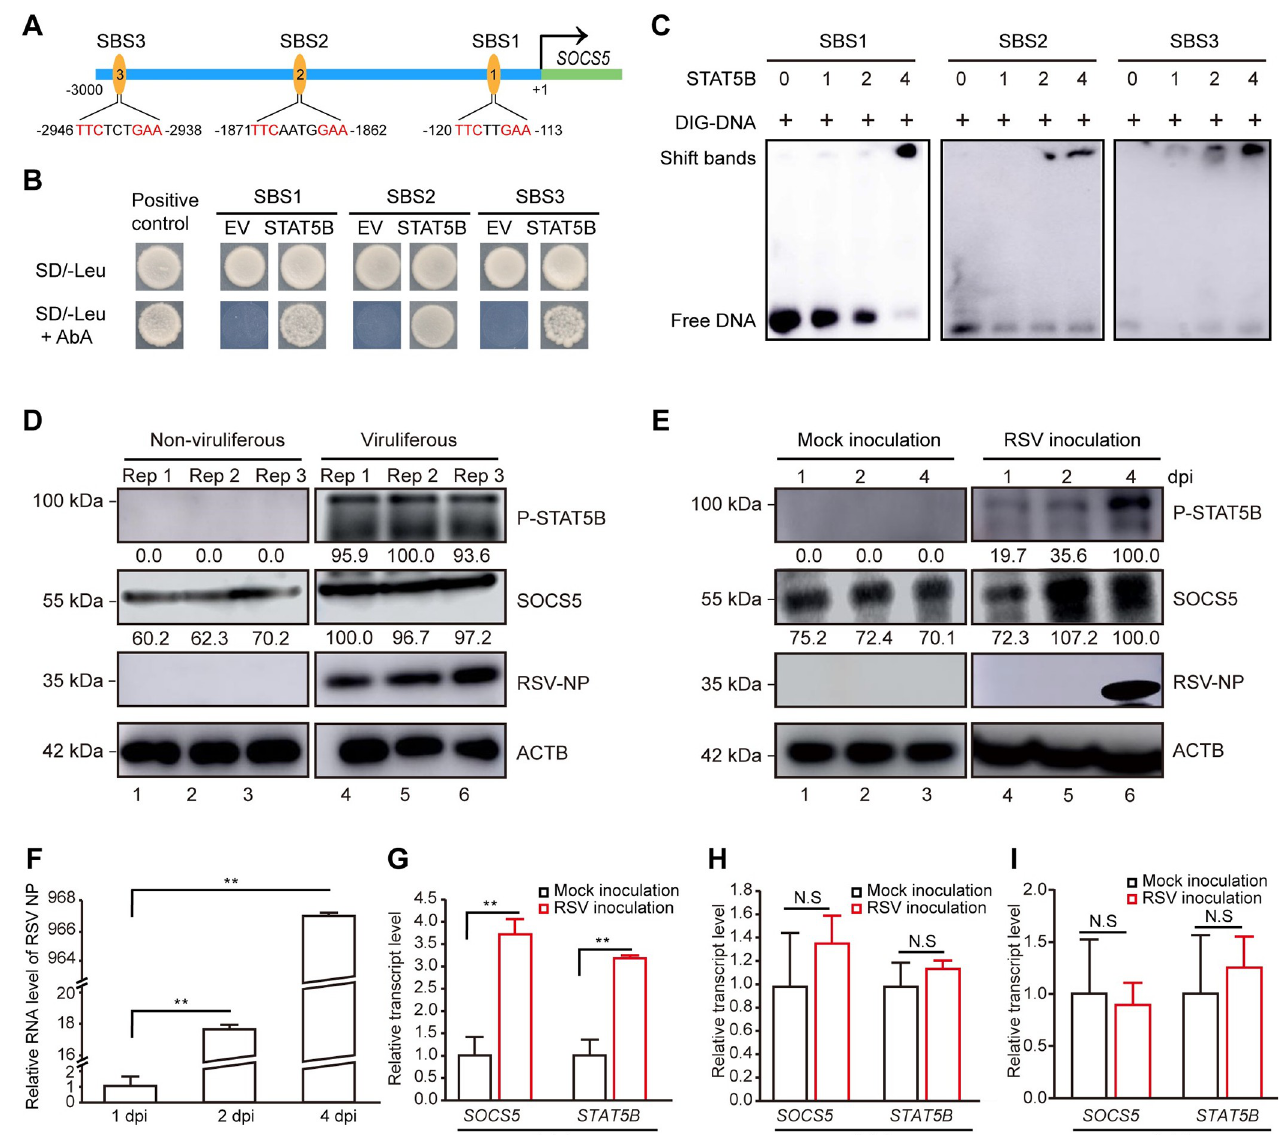
Fig 4. Viral infection activates the JAK-STAT pathway in insect vectors. (A) Schematic diagram showing three putative STAT5B-binding sites (SBS1, SBS2 and SBS3) in the promoter region of SOCS5 gene. (B) Y1H assay verifying the binding of STAT5B to the three binding sites in the SOCS5 promoter. The co- transformed yeast cells were grown on synthetic dextrose (SD) with 25ng/mL AbA lacking leucine (SD/-L+AbA) medium for 4 days at 30˚C. Yeast cells co- transformed with AD-p53+pABAi-p53 acted as a positive control. EV, empty vector. (C) EMSA assay confirming the direct binding of STAT5B to the three binding sites in the SOCS5 promoter. Increasing amounts of STAT5B were incubated with 60 fmol of three DIG-labeled promoters, respectively. (D) Immunoblotting assay presenting the phosphorylated STAT5B (P-STAT5B) and SOCS5 in nonviruliferous and viruliferous SBPHs. (E) Analysis of P-STAT5B and SOCS5 in SBPHs during RSV infection. Insect samples at 1, 2 and 4 days after injection of RSV crude extracts were subjected to immunoblotting using the indicated antibodies. Injection of nonviruliferous crude extracts as a mock inoculation. ACTB was used as a protein loading control. (F) Relative RNA level of RSV NP in SBPHs at 1, 2 and 4 days after injection of RSV crude extracts as determined by qRT-PCR. (G-I) Relative transcript levels of SOCS5 and STAT5B in nonviruliferous SBPHs at 1, 2 and 4 days after injection of RSV were measured by qRT-PCR. The mock inoculation group was injected with nonviruliferous crude extracts. Experiments were performed three independent replicates. N.S., no significant. �� , p < 0.01 by the student t-test. SBPHs. Similar to previous observations, the protein levels of P-STAT5B and SOCS5 signifi- cantly increased and BCL2 accumulation was reduced remarkably (Fig 6A, lanes 1–3 vs. 4–6). In addition, knockdown of STAT5B or SOCS5 also significantly reduced RBSDV acquisition